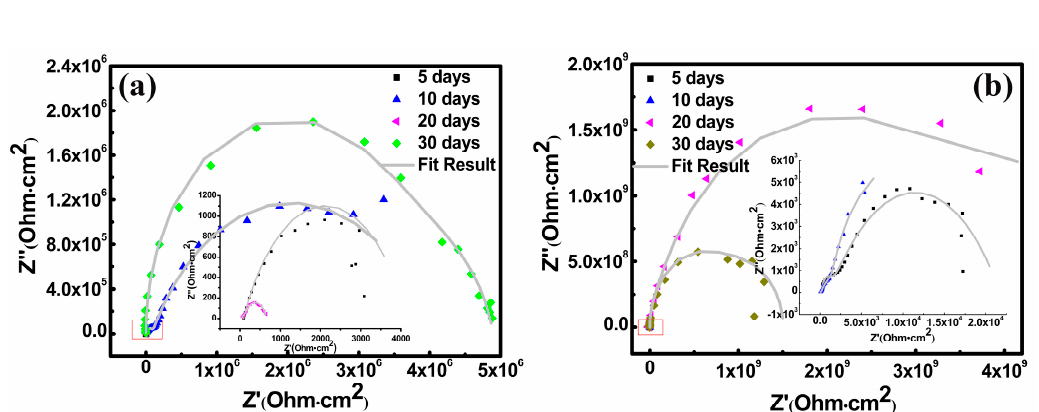
Figure 9. Nyquist plots of ( a ) the uncoated and ( b ) the MAO coated samples.